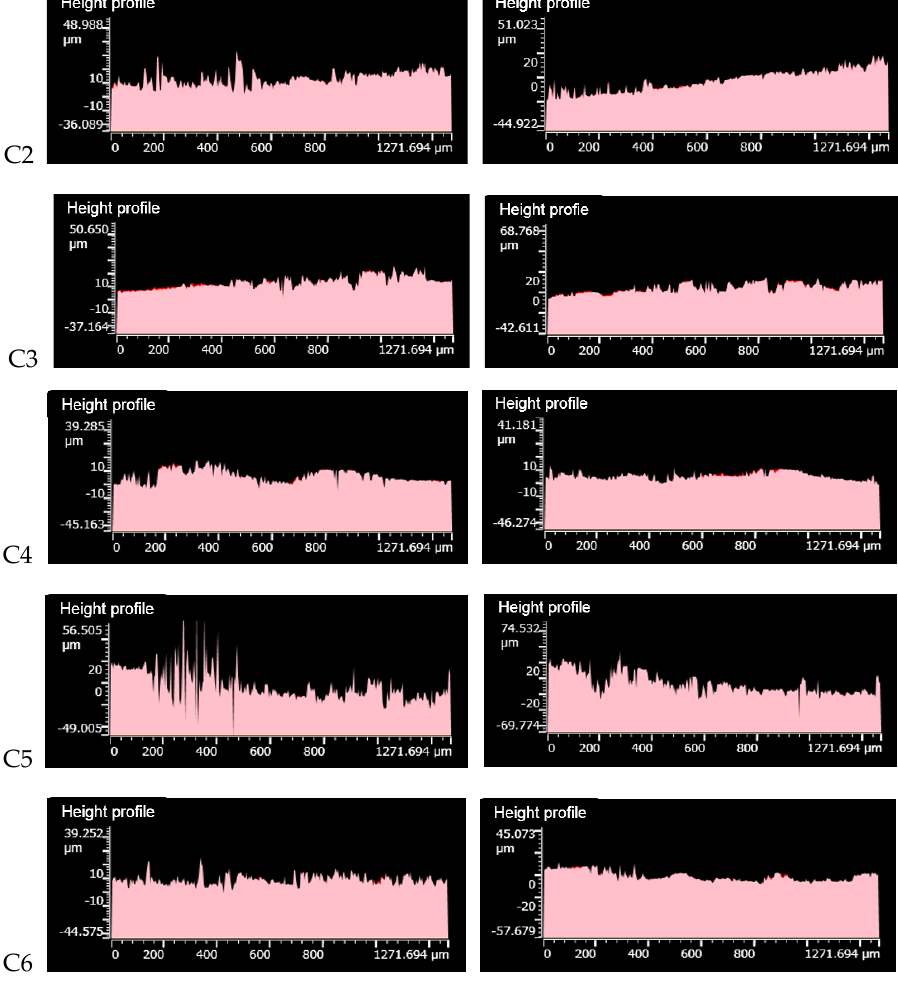
Figure 11. Height profile of metal grinding head before and after friction.